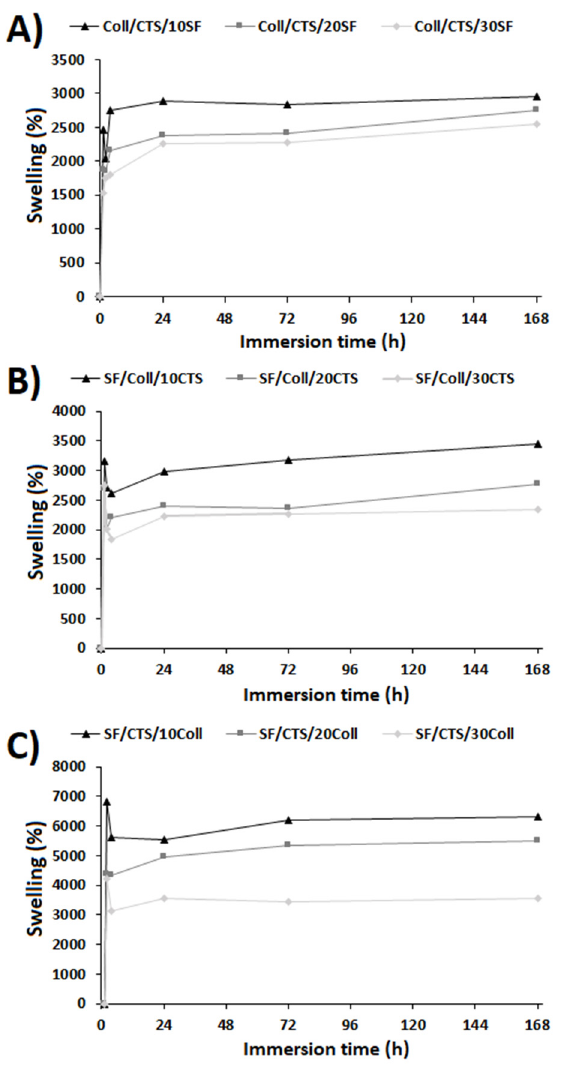
Figure 4. Swelling degree of the three-component materials cross-linked by glyoxal solution: ( A ) Coll / CTS mixture with 10, 20, and 30% SF; ( B ) SF / Coll mixture with 10, 20, and 30% CTS; and ( C ) SF / CTS with 10, 20, and 30% Coll ( n = 3).